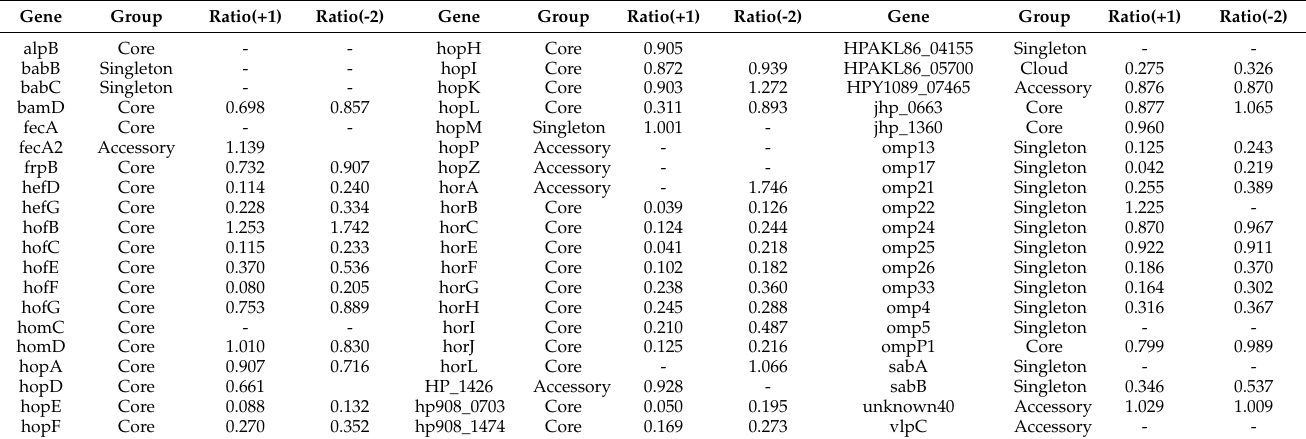
Table 1. Outer membrane proteins annotated in the pangenome, together with the Ka/Ks ratio for both +1 and -2 frames, and the group that they belong. The gene name is that annotated by the functional annotator Sma3s. A hyphen symbol appears when the ratio could not be